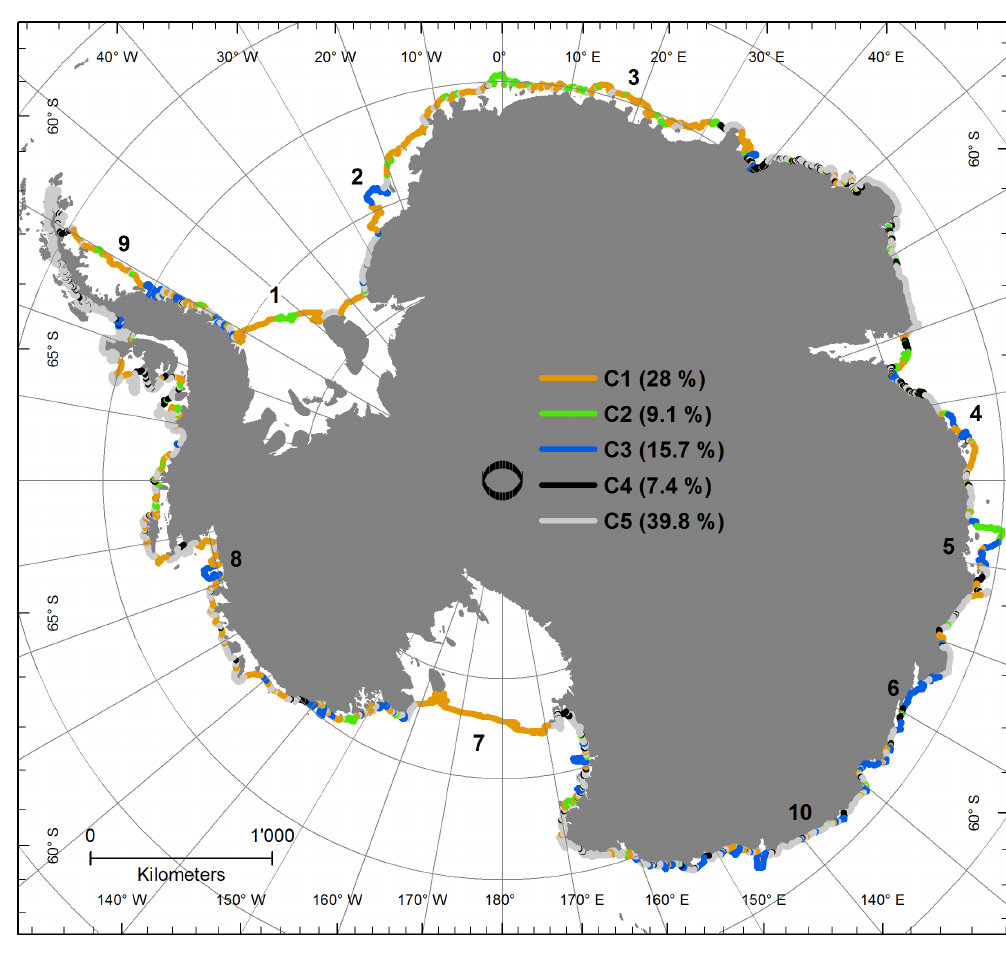
Figure 6. Coastline map with different colors showing different classes. C1 = parallel surface structures, C2 = orthogonal surface structures, C3 = IS pattern, C4 = no crevasses, C5 = grounded ice. The percentages given in brackets give the portion of the class relative the the total length of the coastline. The numbers around the coastline show locations mentioned in the text (please see text). Grounding line (grey) taken from Haran et al . [23].